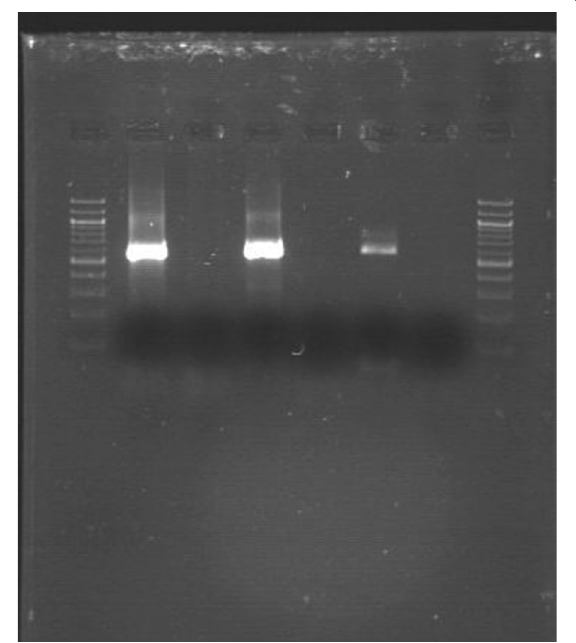
(bp). The image shows the PCR amplified product using mastermix preparation and thermal cycle for hrgA gene. It corresponds to 594 bp when compared with ladder and confirmed the DNA isolated was that of H. pylori . The image was captured by gel documentation.